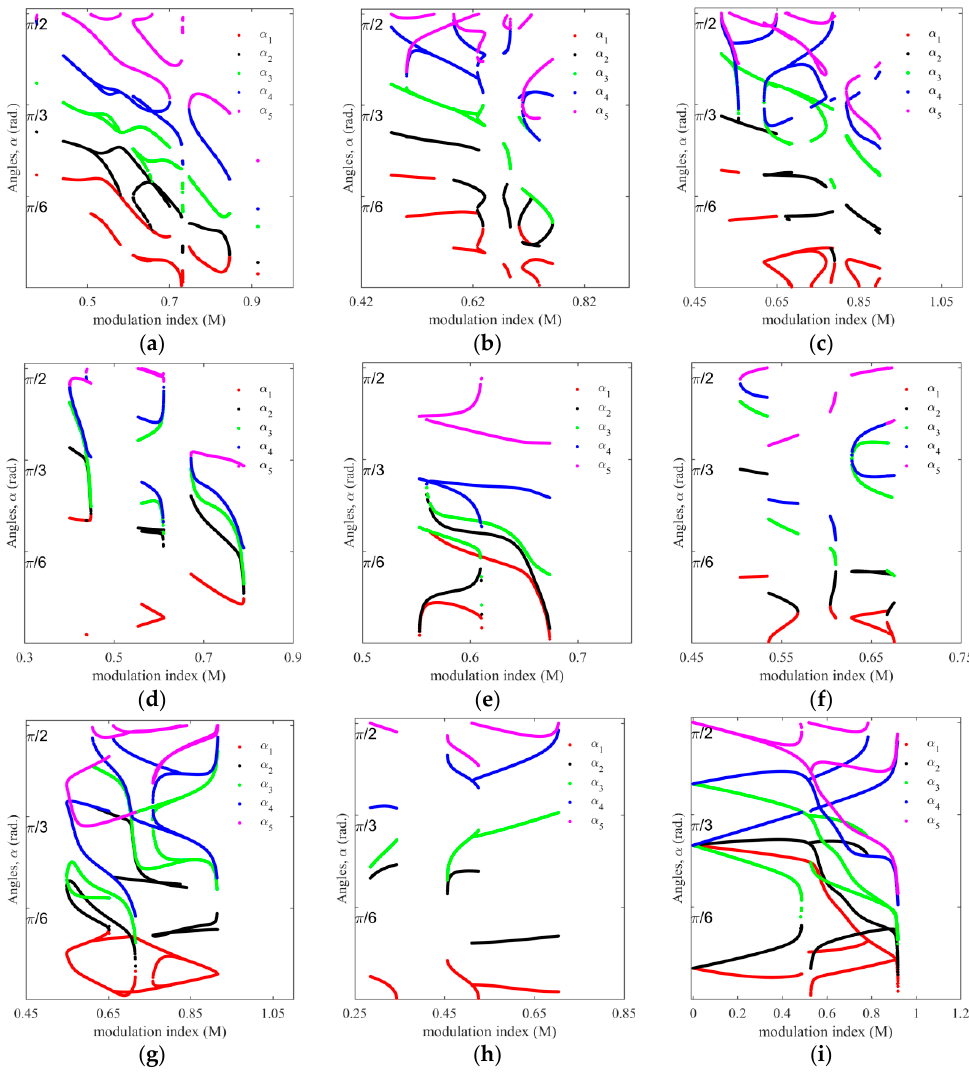
Figure 5. Switching angles (in radians) as function of modulation M for various switching transition ( a ) 54321 ,,,, ; ( b ) 54321 ,,,, ; ( c ) 54321 ,,,, ; ( d )